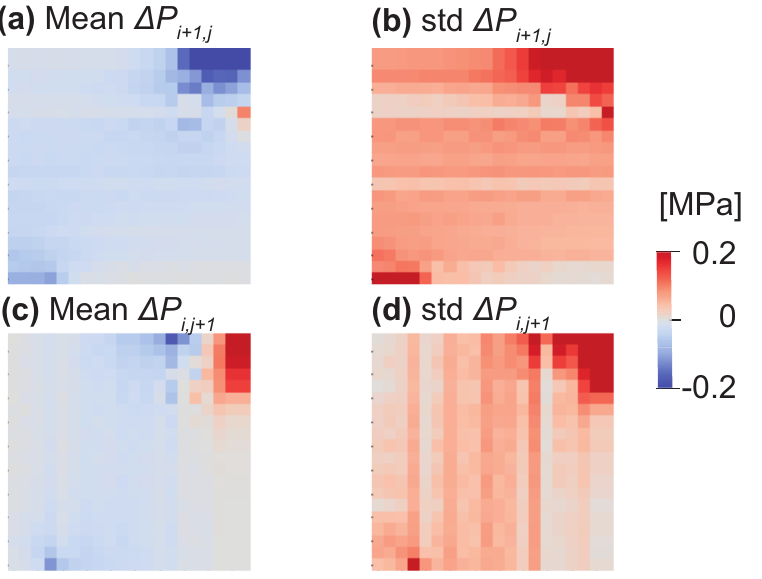
Figure 3. Spatial distributions of mean and standard deviation of pressure differences with downwind for each grid. ( a , c ) The mean and ( b , d ) standard deviation (std) of ∆ P i + 1, j and ∆ P i , j + 1